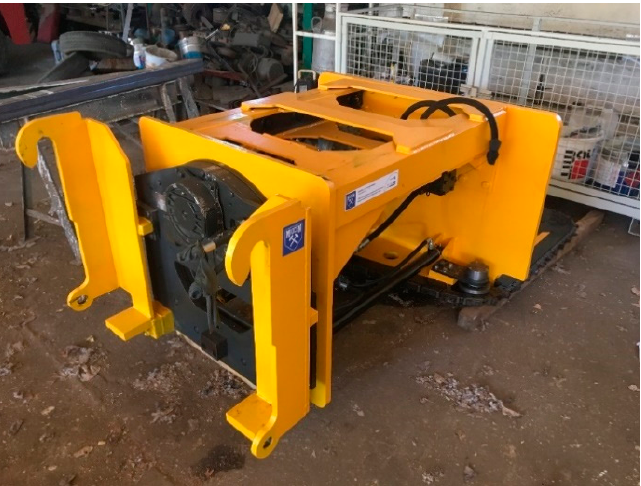
Figure 7. The prototype adapter.